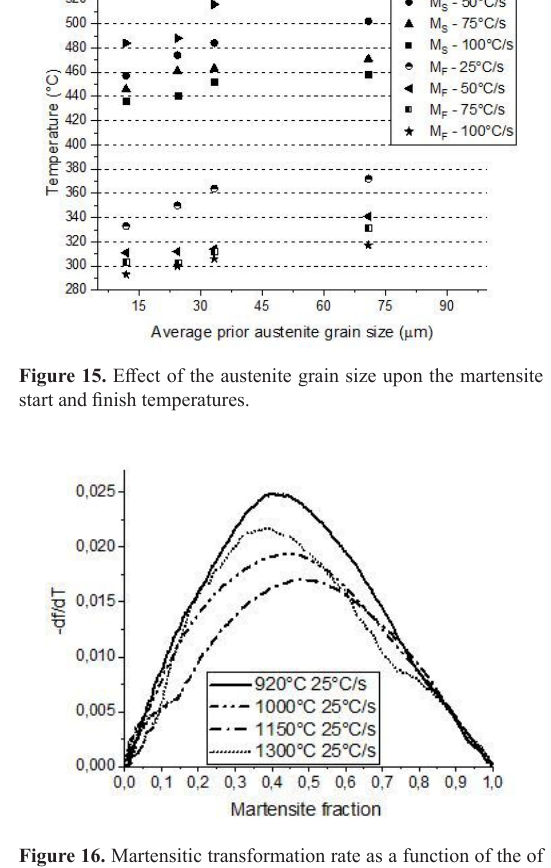
Figure 16. Martensitic transformation rate as a function of the of the martensite fraction for different austenitizing temperatures.